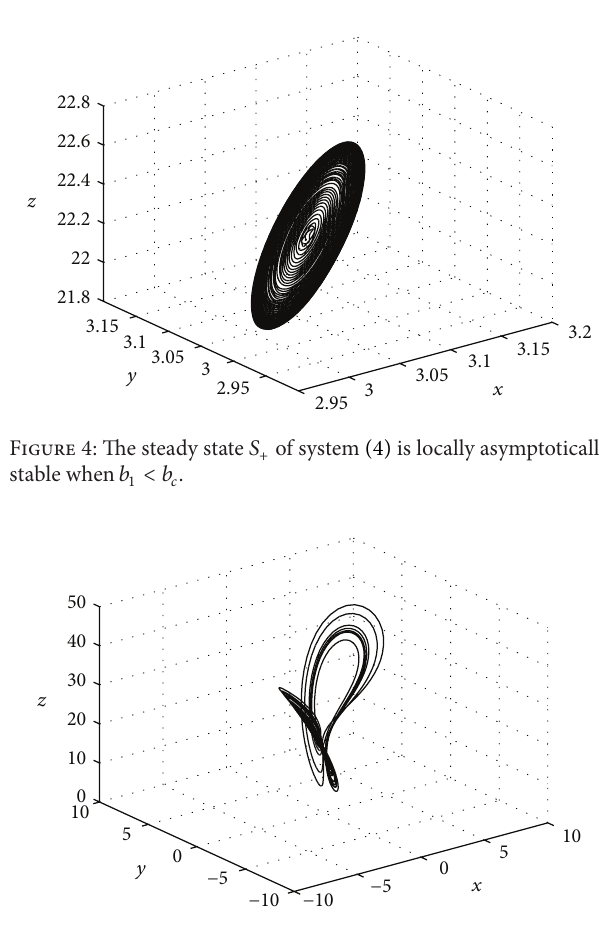
Figure 5: The steady state 𝑆 − of system (4) is unstable when 𝑏 1 > 𝑏 𝑐 .